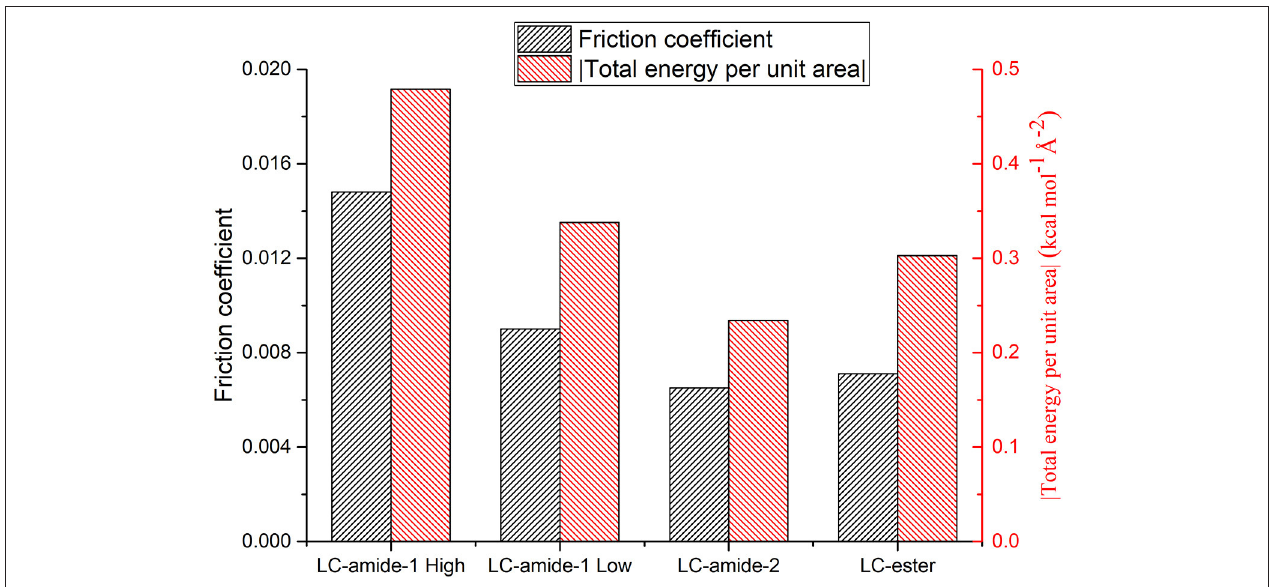
FIGURE 4 | Friction coefficients and total energies per unit area (absolute value) of LC-amide-1 at high/low concentration, LC-amide-2, and LC-ester.